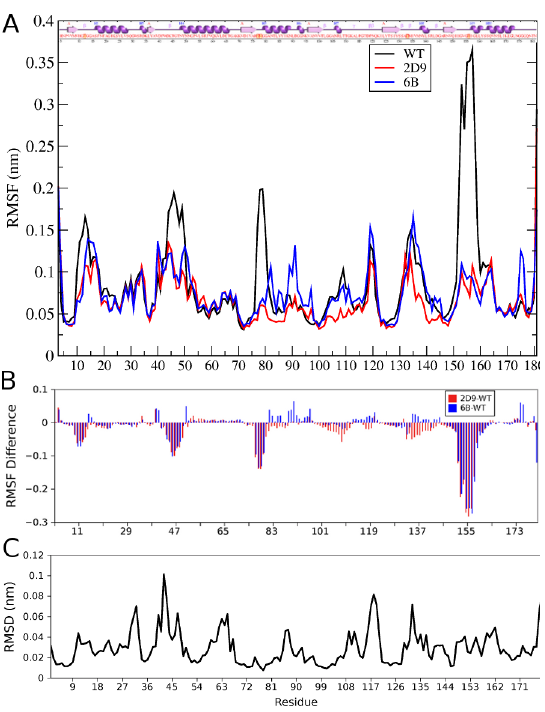
Figure 11. Flexibility analysis of WT and mutants. A) The RMSF values of all residues in WT, 2D9 and 6B from MD simulations. B) The difference in the RMSF values of the mutant 2D9 (Red bars) and 6B (Blue bars) and the WT. C) Residue wise RMSD obtained after aligning the seven structures of Lipase A.